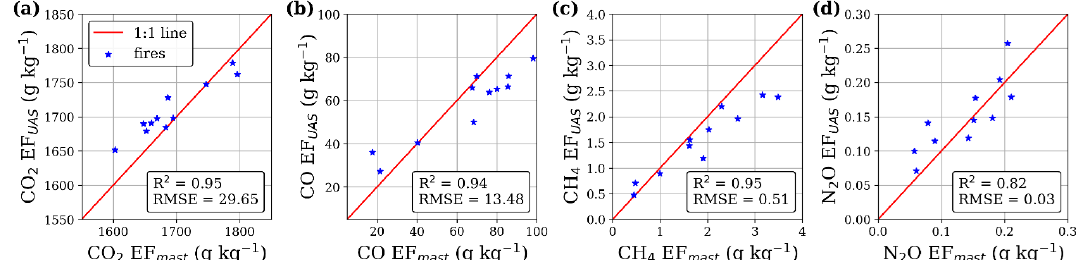
Figure 3. Correlation between the UAS-derived EF and the EF derived from the mast at the same time window for prescribed fire experiments in the KNP. Each marker represents the EF calculated over the integrated measurements of a fire by the mast and UAS-sampled bags respectively. The 1 : 1 line is shown in